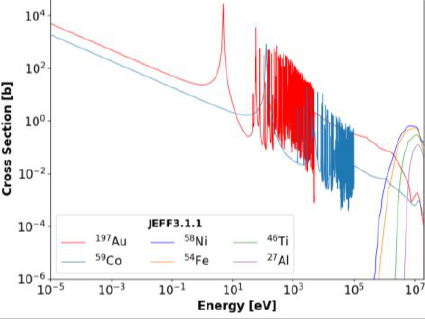
Fig. 5. Cross-sections for resonant and threshold dosimeters from JEFF3.1.1 nuclear data library